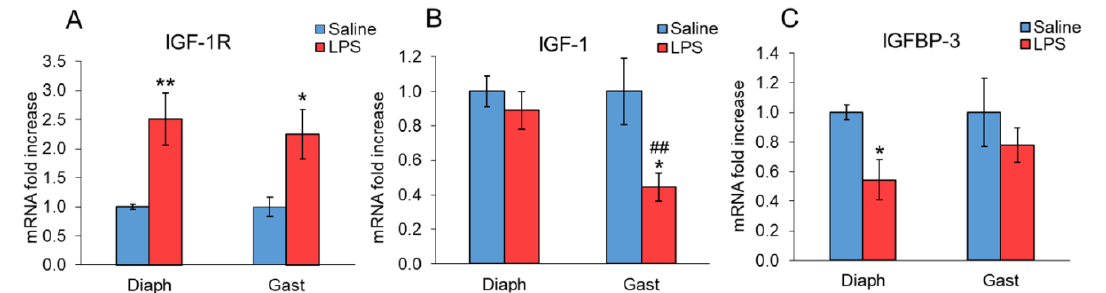
Figure 4. Effect of sepsis induced by LPS injection (10 mg/kg ip.) on ( A ) IGF-1R, ( B ) IGF-1 Ea (IGF-1), and ( C ) IGFBP-3 mRNA, in rat diaphragm and gastrocnemius muscles, 24 h after a single injection of LPS or saline solution. mRNA was measured by PCR. The data represent mean ± standard error of the mean (SEM) for n = 7–8 rats/group. * p < 0.05 and ** p < 0.01 versus their respective control rats treated with saline, ## p < 0.01 versus diaphragm of rats treated with LPS. Diaph: diaphragm, Gast: gastrocnemius.